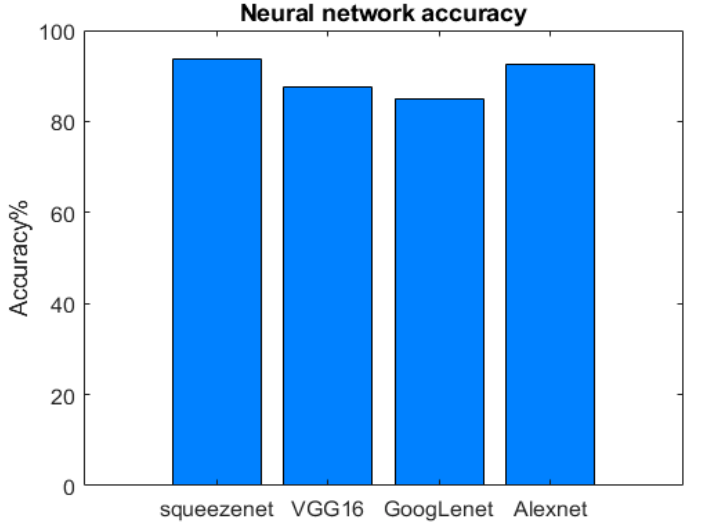
Figure 9. Overall accuracy of DL Networks in object detection for SSA applications. Table 4. Precision, Recall, and F-measure of DL Networks for SSA space debris